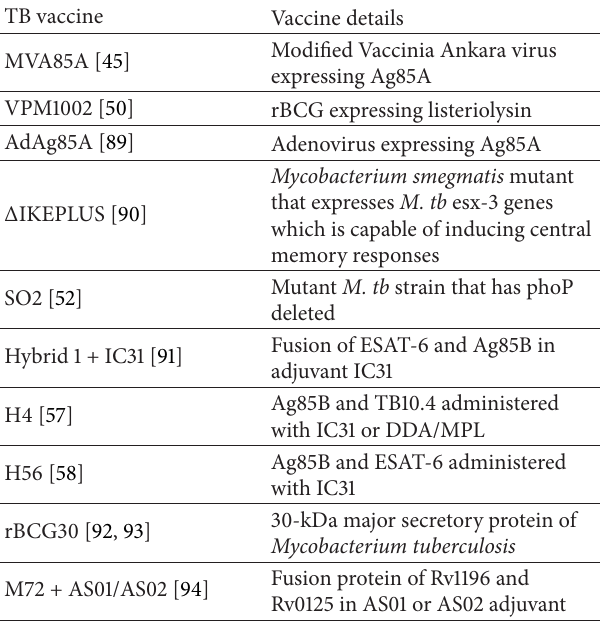
Table 1: Candidate vaccine with emerging protective responses and its brief description.